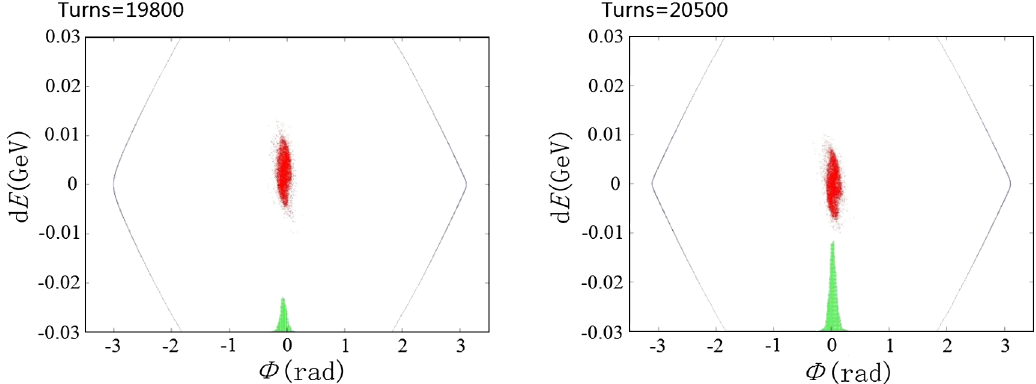
FIG. 5. Longitudinal beam distributions just before the extraction in the nominal operation mode with bunch compression (Left: without desynchronization; right: with de-synchronization.)